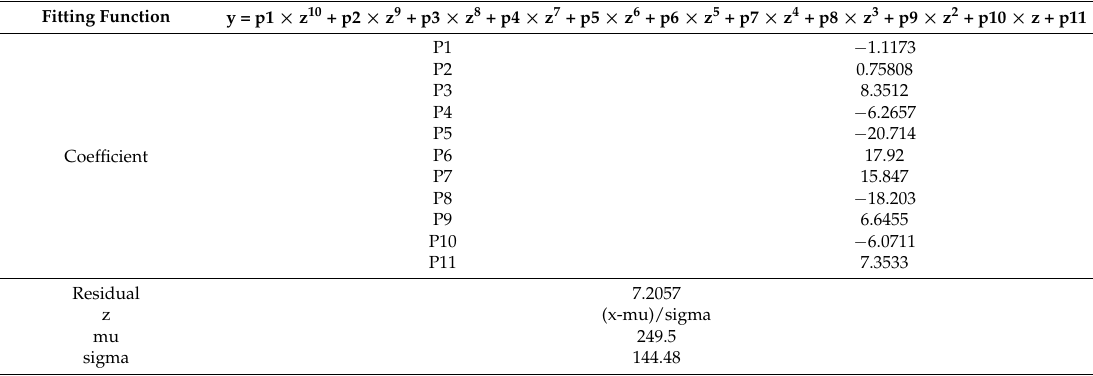
Table 4. Fitting function and all the